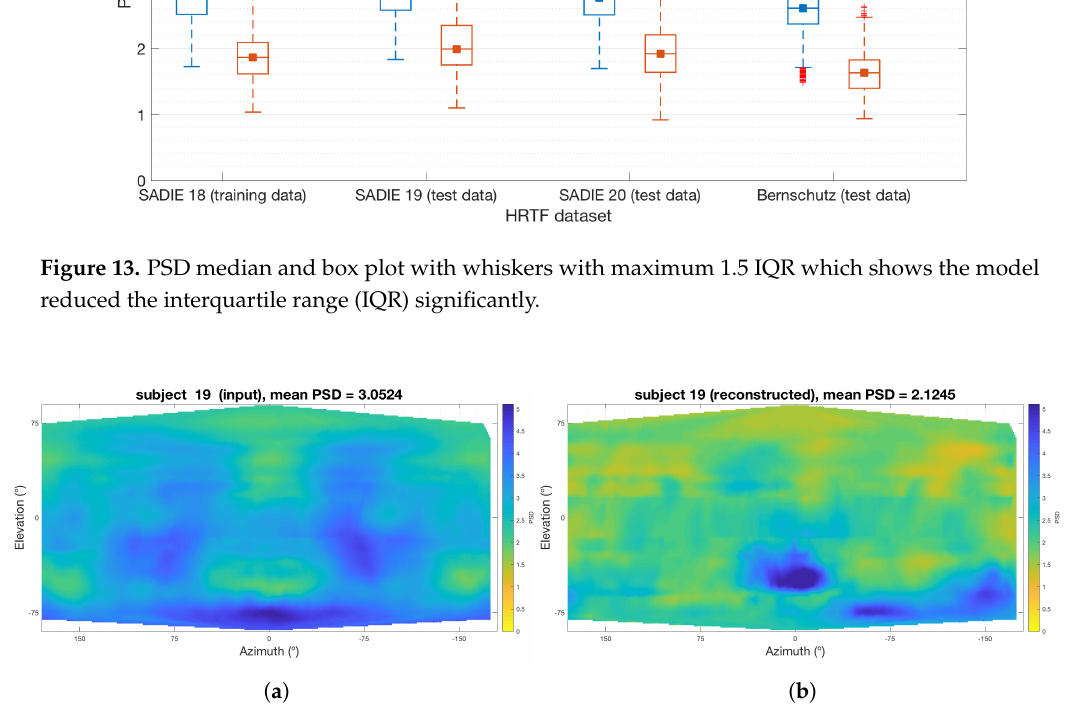
Figure 14. Comparing the PSD of Subject 19 from SADIE II database before and after reconstruction, which shows a noticeable improvement in most regions, besides the very low frontal region. ( a ) Before reconstruction. ( b ) After reconstruction.